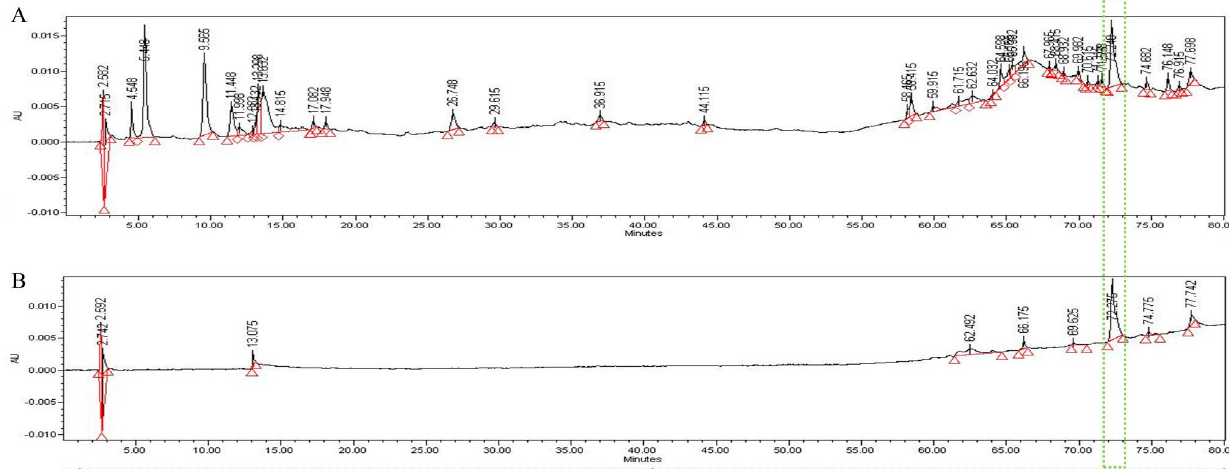
Figure 6. HPLC pattern for UF extract ( A ) and UDCA ( B ). The main compound in UF, UDCA, was identified based on the retention time and chromatogram pattern of an authentic standard. Peak 1 with a retention time of 72.275 min corre- sponds to UDCA.